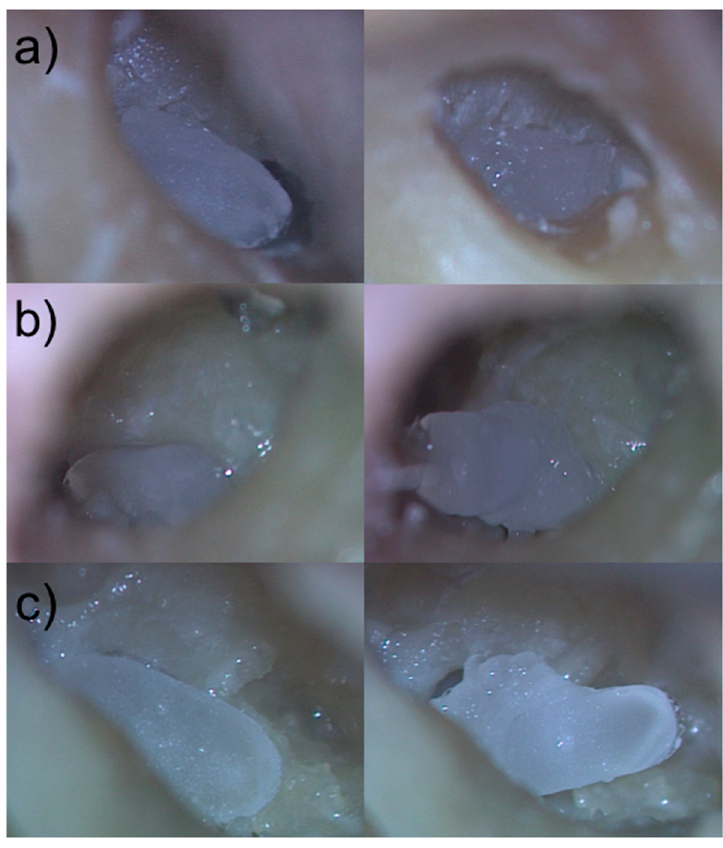
Figure 7. Comparison of manually segmented to semi-automatically segmented and 3D printed RNI in the corresponding human cadaver RWN. ( a – c ) left images: 3D printed individualized semi-automatically segmented RNI of the human cadaver RWN in their final position in the RWN ( a – c ) right images: 3D printed individualized manually segmented RNI of the human cadaver RWN laying above the bony edges of the RWN. Table 2. Rating matrix for performance evaluation of the RNI with a rating scale from 1 to 6. 1: very good (green); 2: good (light green); 3: acceptable (yellow); 4: sufficient (light orange); 5: inadequate (orange); 6: insufficient